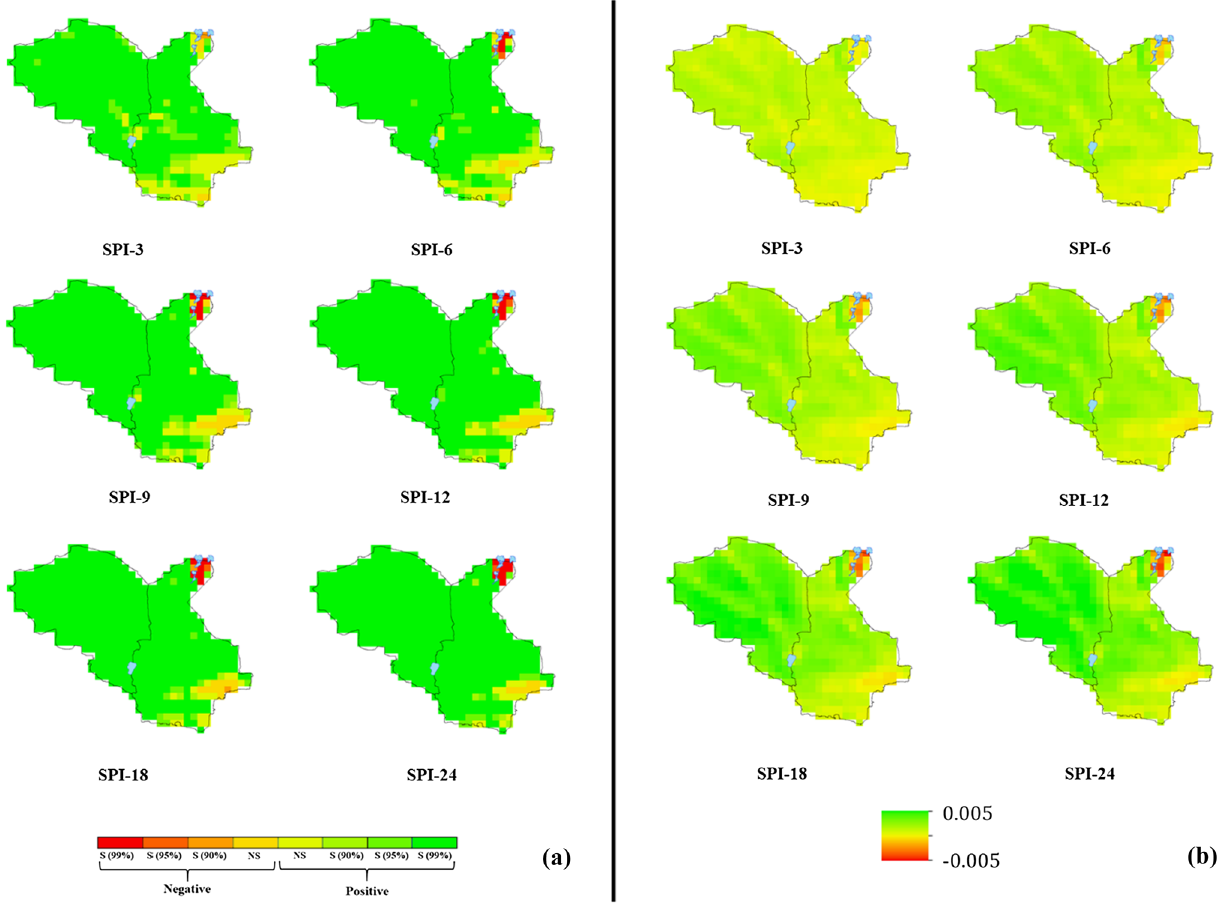
Fig. 6 Spatial distribution of a trend and b Sen’s slope of the SPI time series over the southeast of